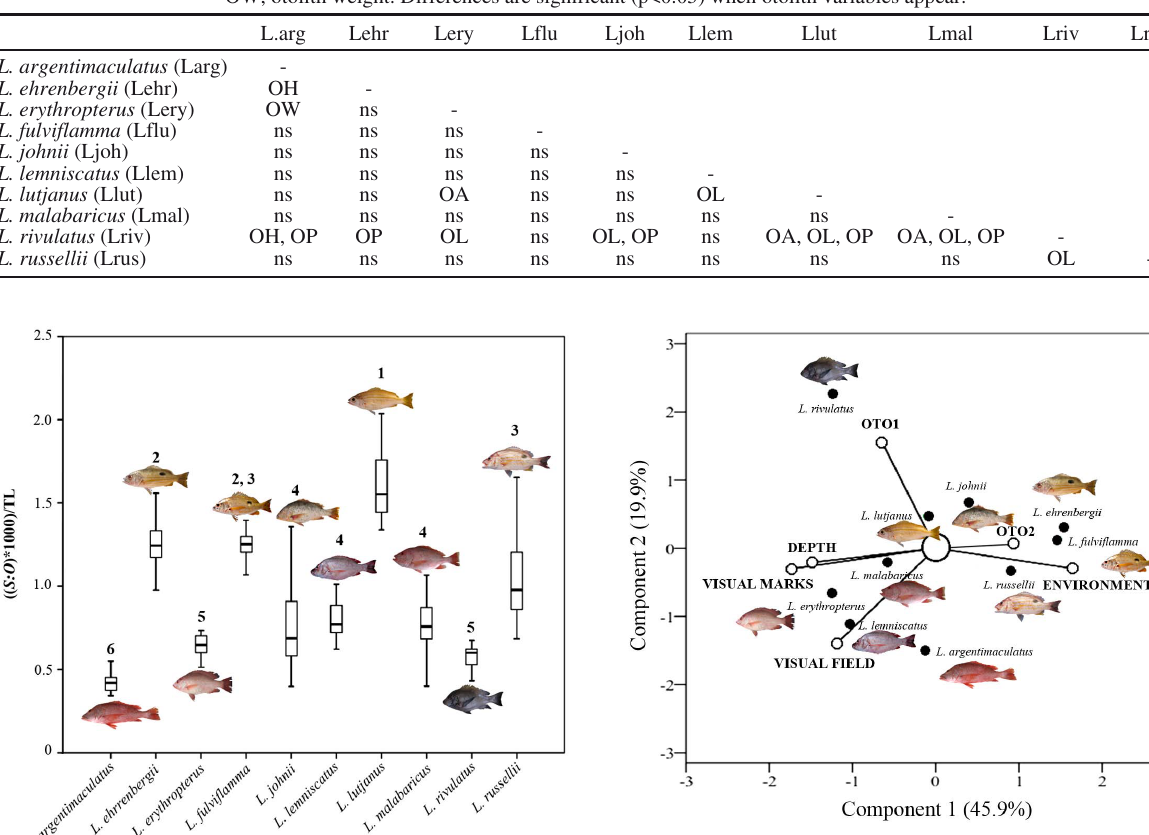
Fig . 5. – Scatterplot of the CatPCA analysis of ecological, func- tional and morphological factors influencing the ecomorphological distribution of snappers from the Persian